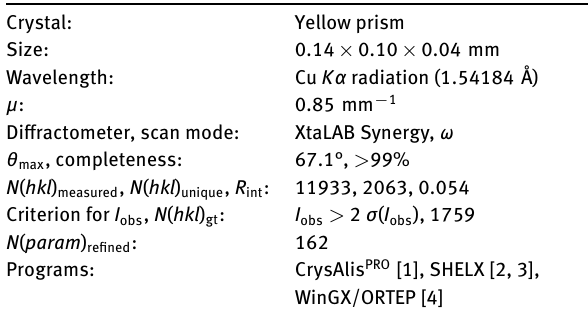
Table 1: Data collection and handling.